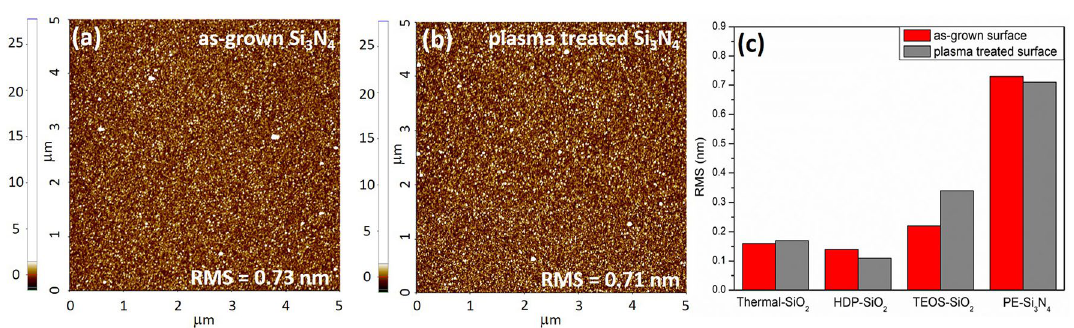
Figure 5. Surface morphology (5 × 5 µm) of PE-Si 3 N 4 films measured by Atomic Force Microscopy: ( a ) as-grown PE-Si